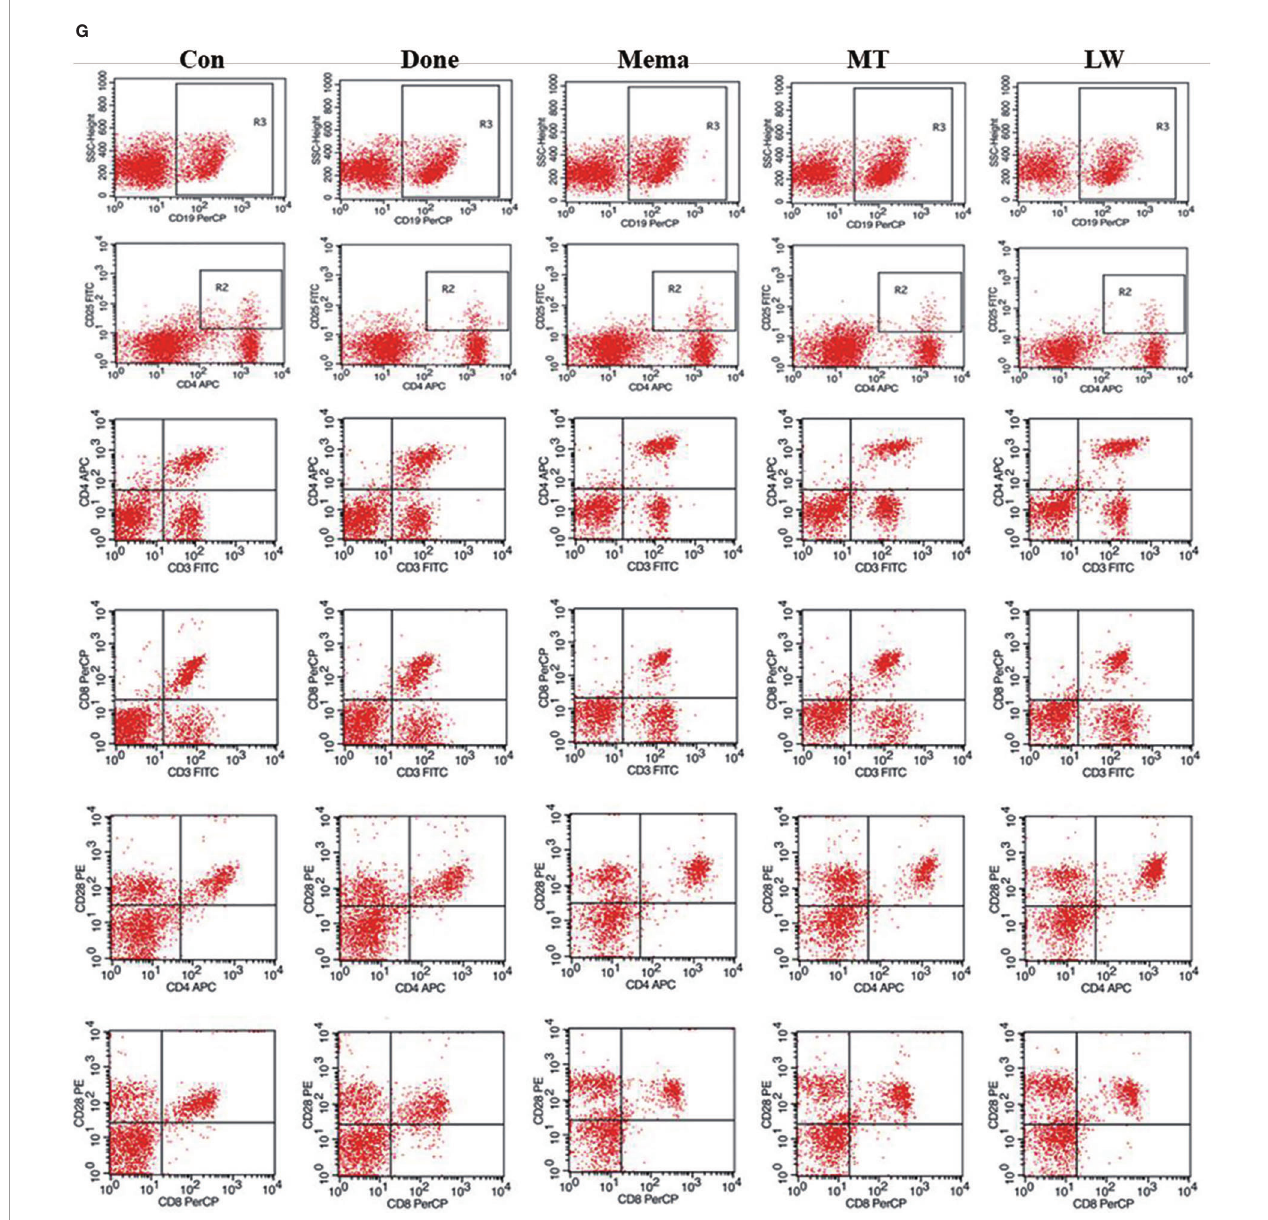
FIGURE 4 | Effects of donepezil, memantine, melatonin, and LW on lymphocyte subsets of splenocyte in old SAMR1 mice. 1× 10 6 spleen cells isolated from mouse (n = 6) spleen were harvested, (A) CD19 + B cells, (B) CD3 + CD4 + T cells, (C) CD3 + CD8 + T cells, (D) CD4 + CD25 + T cells, (E) CD4 + CD28 + T cells, (F) CD8 + CD28 + T cells quanti fi ed by fl ow cytometry. * P < 0.05, ** P < 0.01, *** P < 0.001 vs control, one-way ANOVA and Dunnett test. mean ± S.D., n=6~9(male: n = 2~4, female: n = 4~6). (G) The scatter plot of lymphocyte